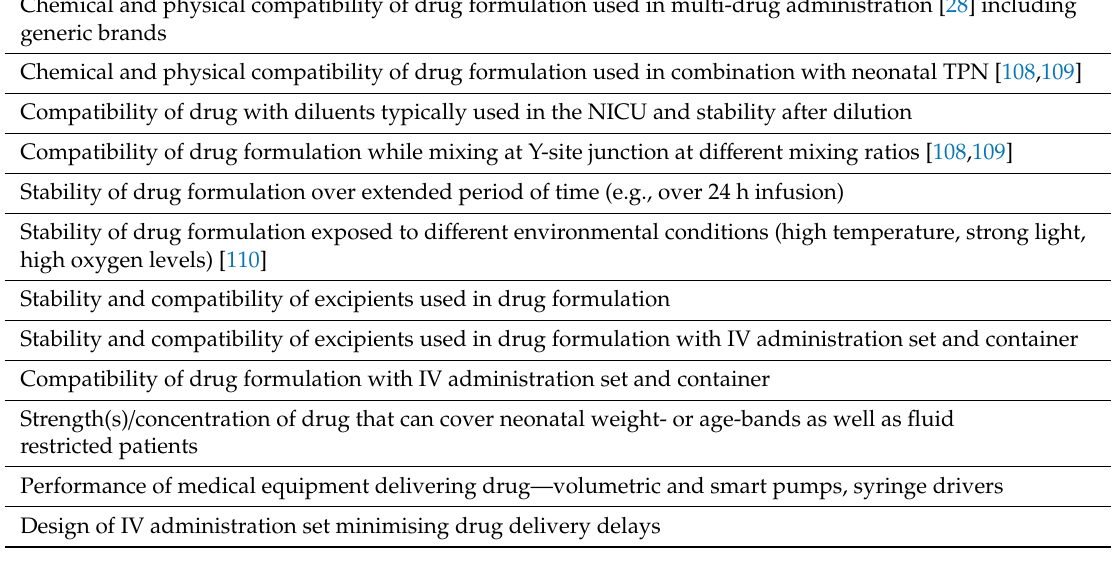
Table 2. Factors to consider in neonatal parenteral drug formulation and